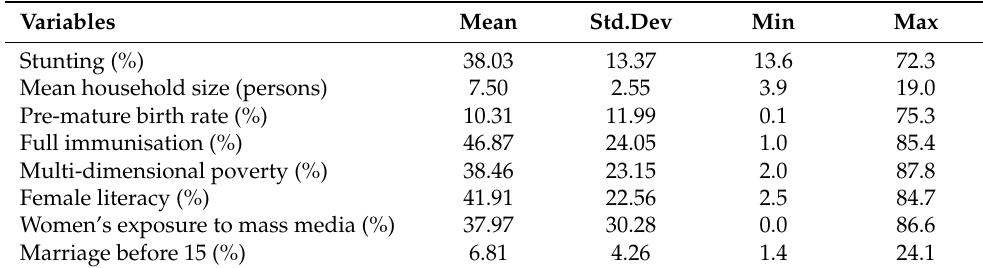
Table 1. Descriptive statistics of analysed data for Pakistan